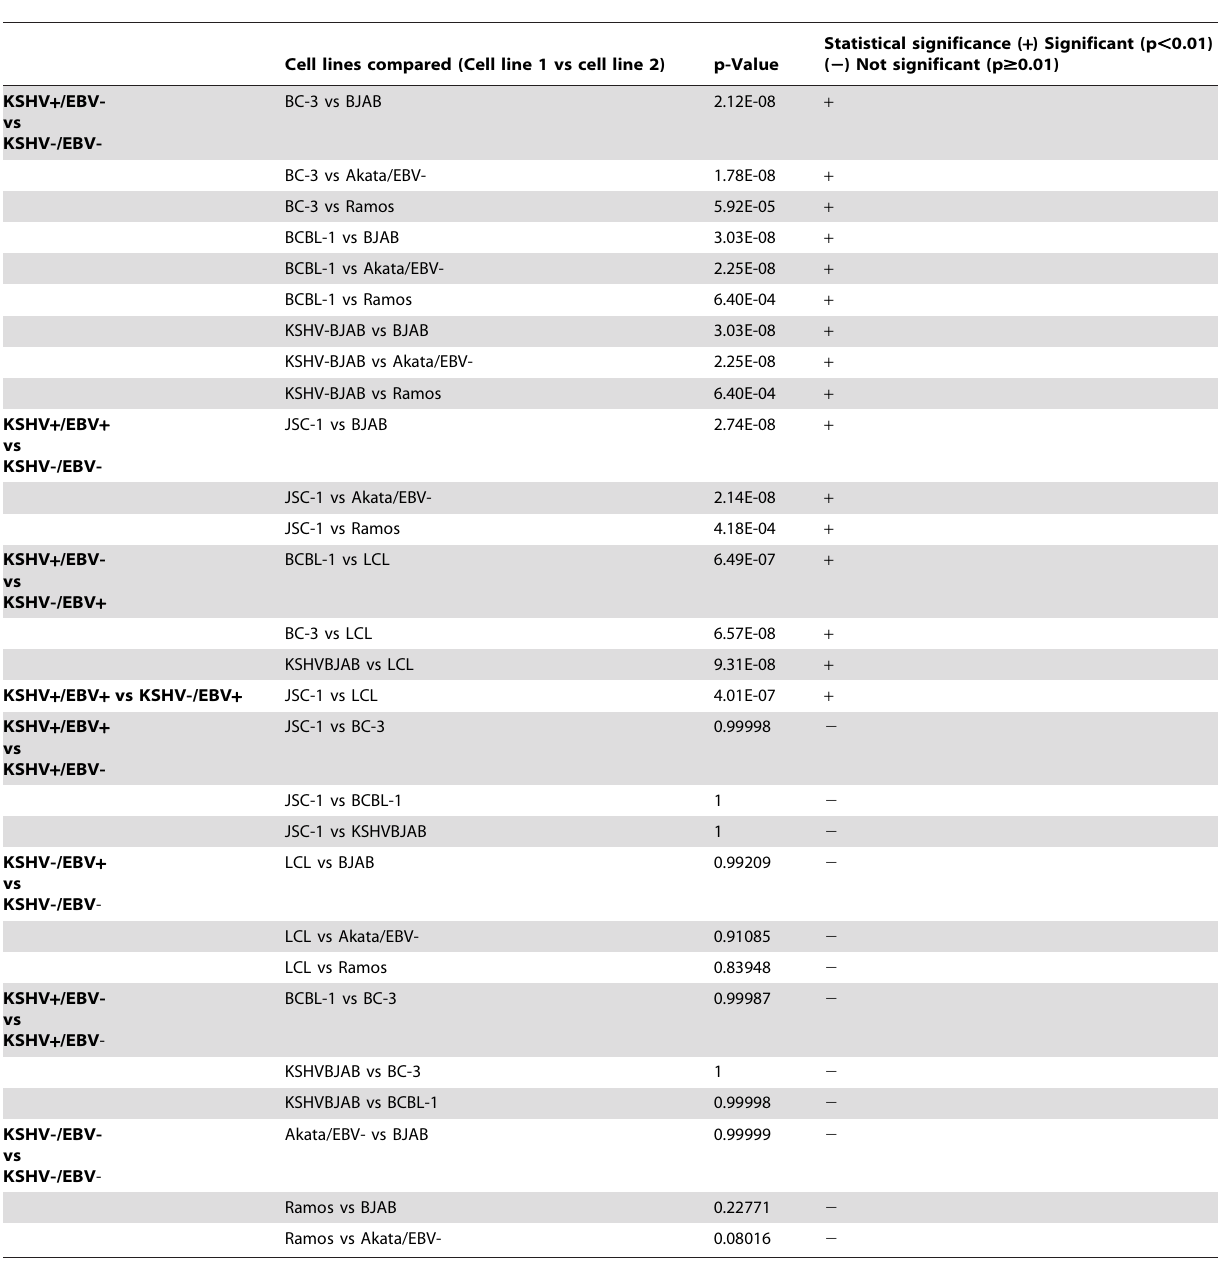
Table 1. Tukey posthoc analysis of the differences in the means of the proliferative capacity of different cell lines at 1 day post- treatment with 50 m M